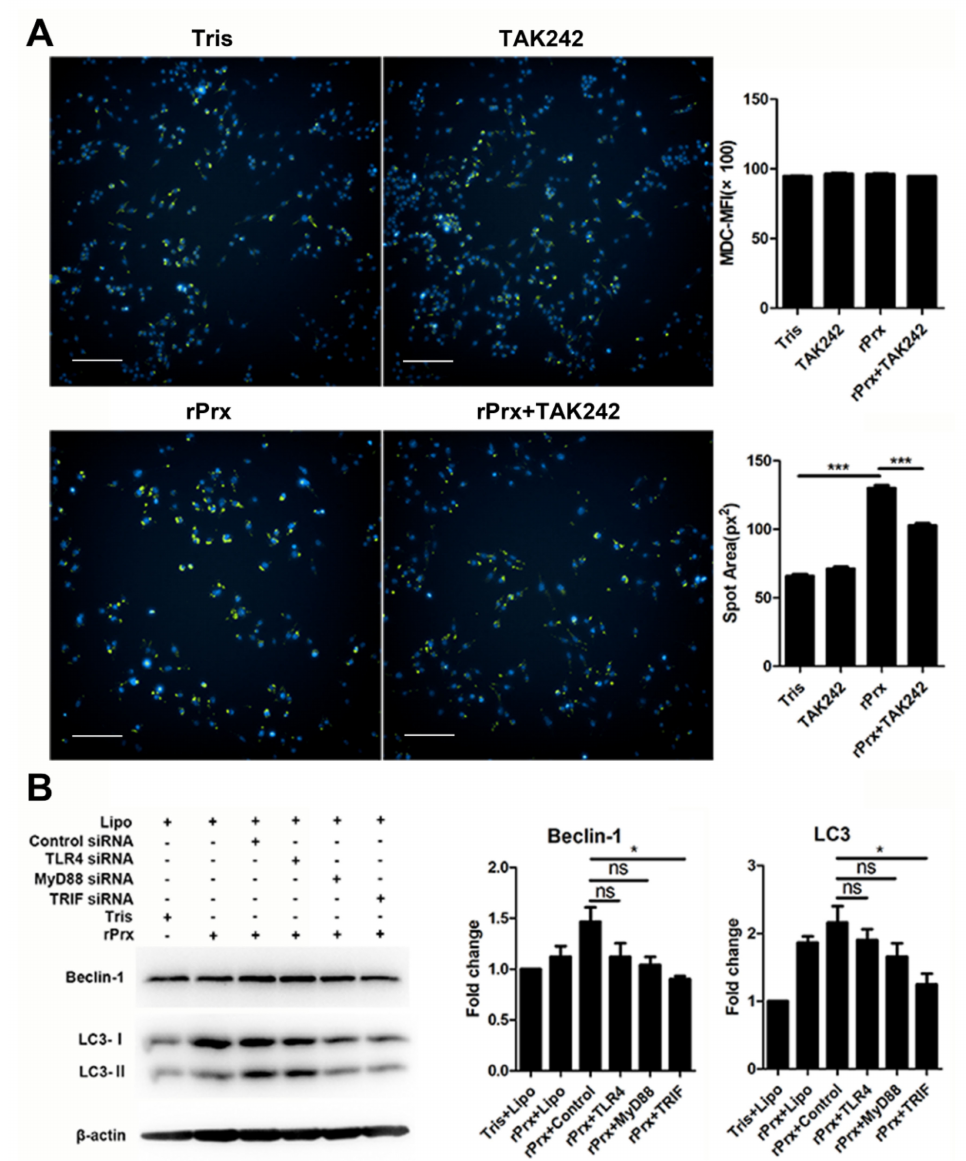
Figure 3. Eh -rPrx activated autophagy via the toll-like receptor 4 (TLR4)–TRIF signaling pathway. ( A ) Eh -rPrx induced autophagosome formation through TLR4. RAW264.7 cells were pre-treated with the TLR4 inhibitor TAK242, incubated with Eh -rPrx for 24 h, and stained with monodansylcadaverine (MDC) (green) and Hoechst 33342 (blue). Tris-HCl (pH 8.0) was used for the negative control. The spot area of MDC fluorescence was quantitatively assessed by high-content screening analysis ( n = 5). Scale bar: 100 µ m. ( B ) Autophagy induction by Eh -rPrx occurred through the TLR4–TRIF signaling pathway. RAW264.7 cells were pre-treated with TLR4-, MyD88-, or TRIF-specific siRNAs for 24 h, treated with Eh -rPrx (5 µ g / mL) for 24 h, and analyzed for the expression of Beclin-1 and LC3 by Western blotting ( n = 3). Tris-HCl (pH 8.0) was used for the negative control. The data are expressed as the mean ± SEM; * p < 0.05 and *** p < 0.001 by Student’s t -test; ns, not